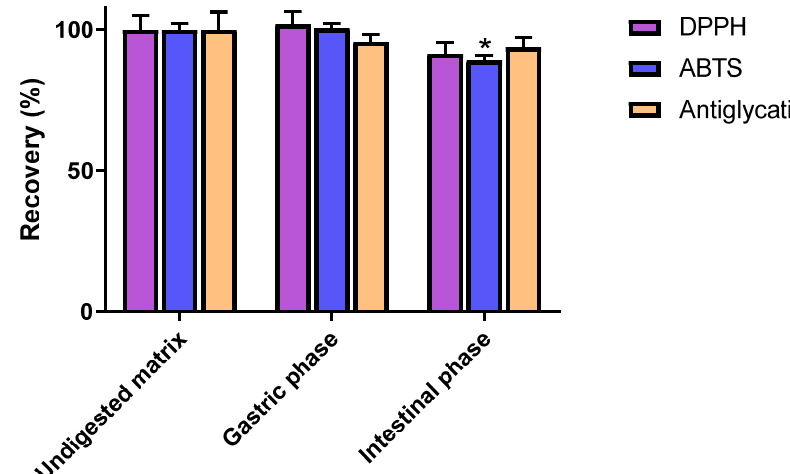
Figure 3. Recovery rates of radical scavenging (DPPH, ABTS) and antiglycation activities after in vitro digestion of cyanidin-3- O -glucoside. Data are indicated as means ± SEM ( n = 3). All results are expressed as percentages, with the control (i.e., undigested matrix) normalized as 100%. * p < 0.05 vs. control (undigested matrix). DPPH: 2,2-diphenyl-1-picrylhydrazyl, ABTS: 2,2 ′ -azino-bis 3-